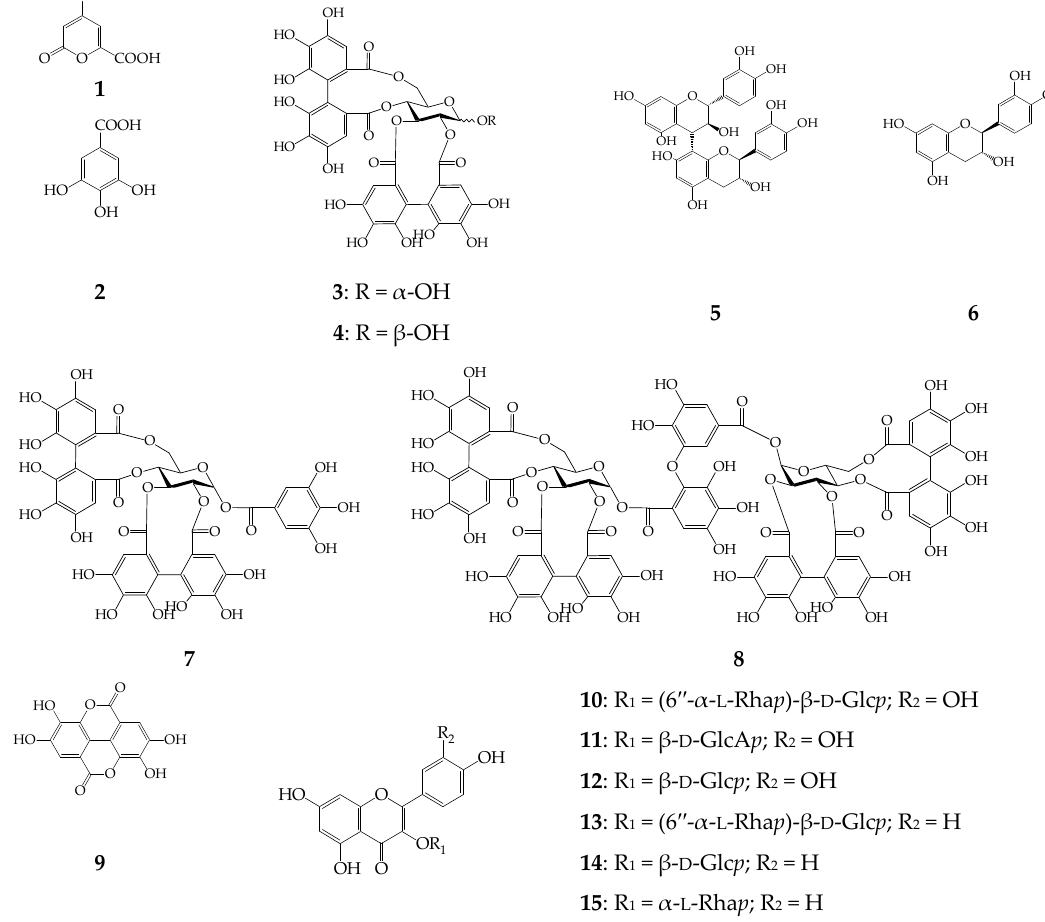
Figure 2. Chemical structures of compounds 1 – 15 detected in C. palustre extract. β - D -Glcp— β - D - glucopyranose; β - D -GlcAp— β - D -glucuronopyranose; α - L -Rhap— α - L